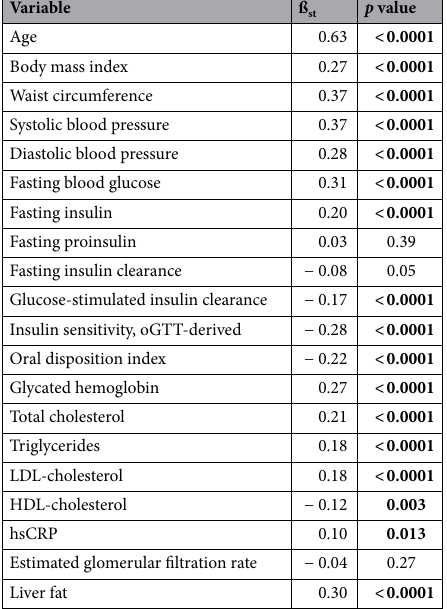
Table 2. Univariate associations of carotid intima-media thickness with demographic and metabolic characteristics. A p -value < 0.05 was considered statistically significant and is given with bold values.